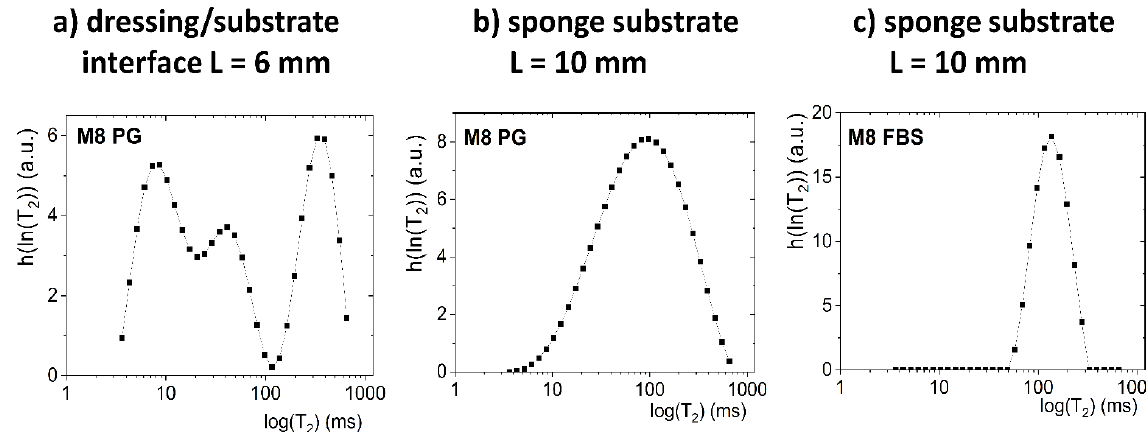
Figure 5. The Laplace inversion of the data obtained at 15 min after application on the substrate for: ( a ) M8 sample on PG and ROI placed at the dressing/substrate interface ( L = 6 mm); ( b ) M8 sample on PG and ROI in sponge substrates concentrated at around L = 10 mm; ( c ) M8 sample on FBS and ROI in a sponge substrate concentrated at around L = 10 mm.